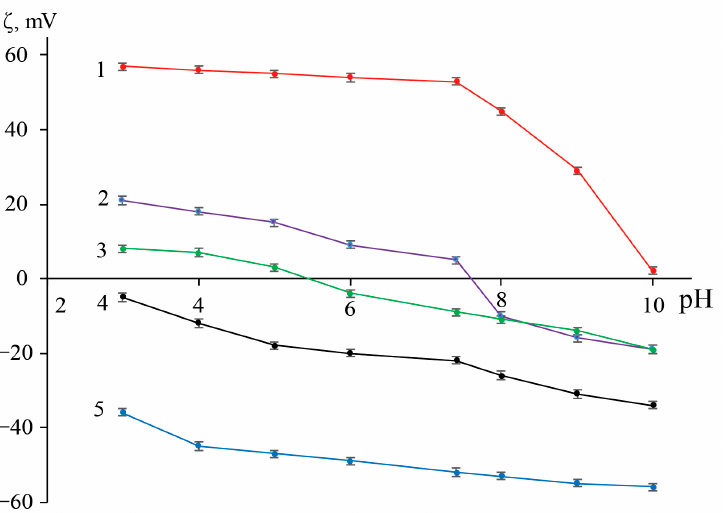
Figure 4. pH-responsive zeta-potential of original and functionalized IONs. Traces: (1)—Fe 3 O 4 @PSS, (2)—Fe 3 O 4 @Carb, (3)—Fe 3 O 4 @Dex, (4)—Fe 3 O 4 , and (5)—Fe 3 O 4 @PEI ( n = 3, p = 0.95).